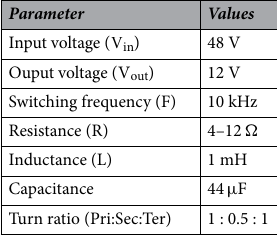
Table 1. Circuit parameters of forward converter.